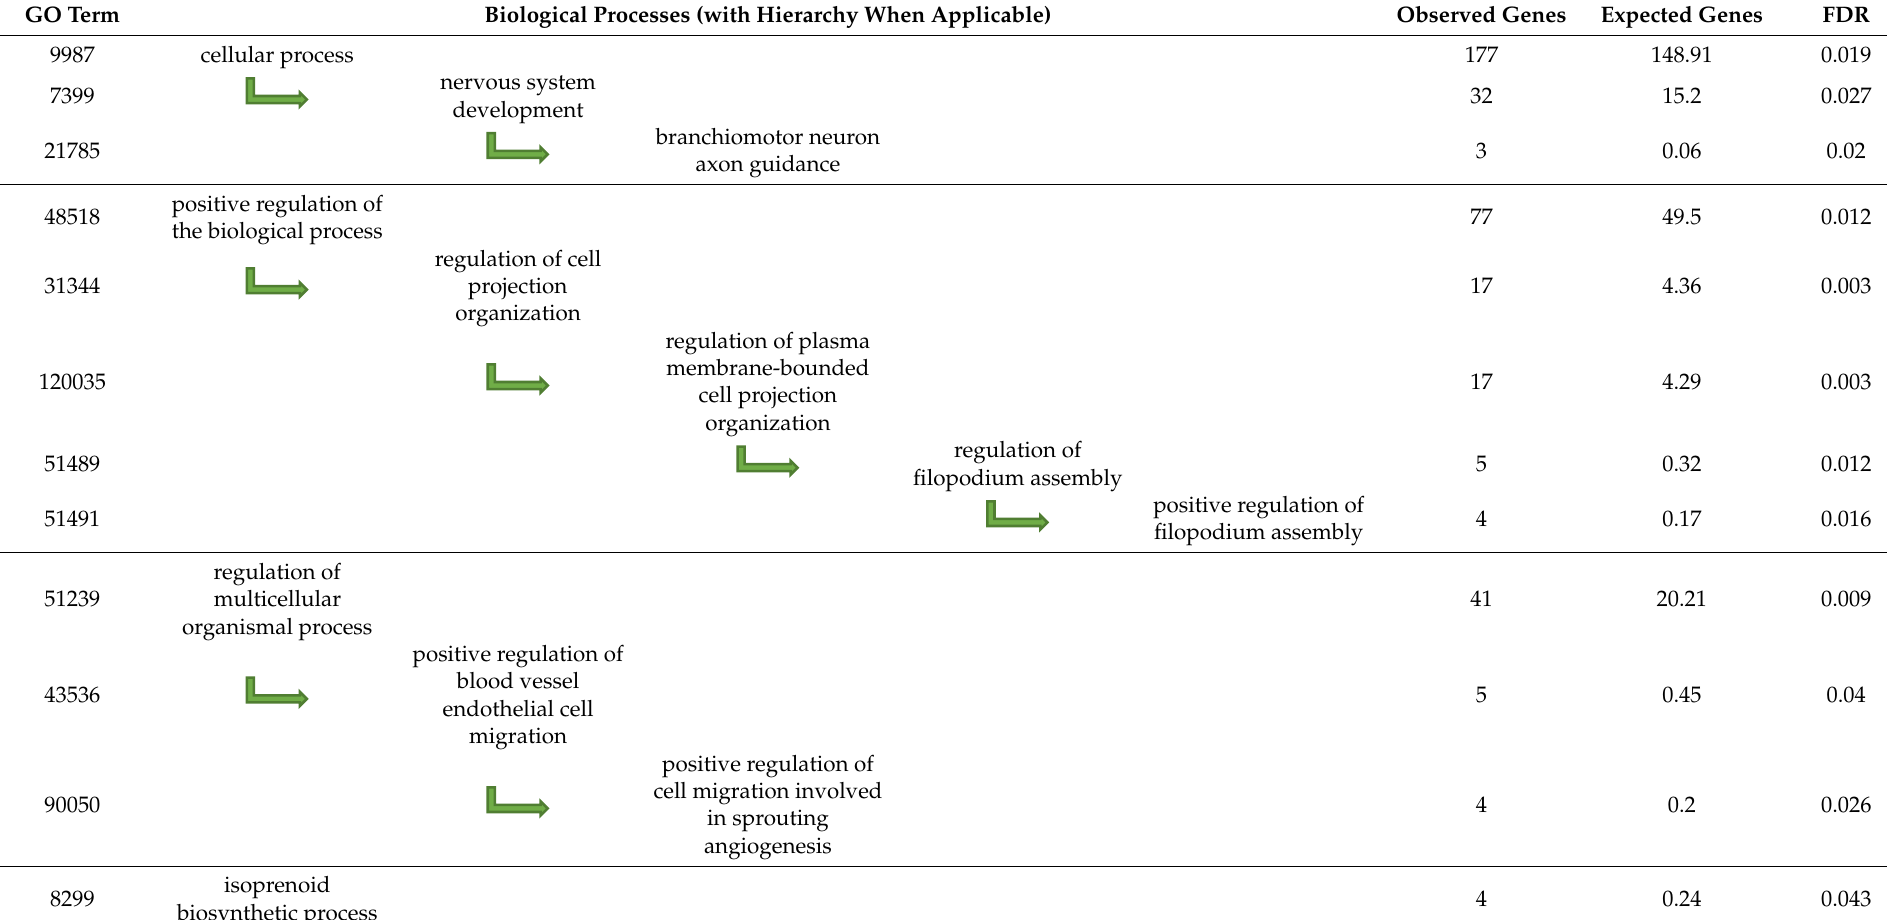
Table 5. Gene Ontology analysis for genes associated with total number born, number born alive, number of stillborn, litter birth weight, and corpus luteum number in pigs.